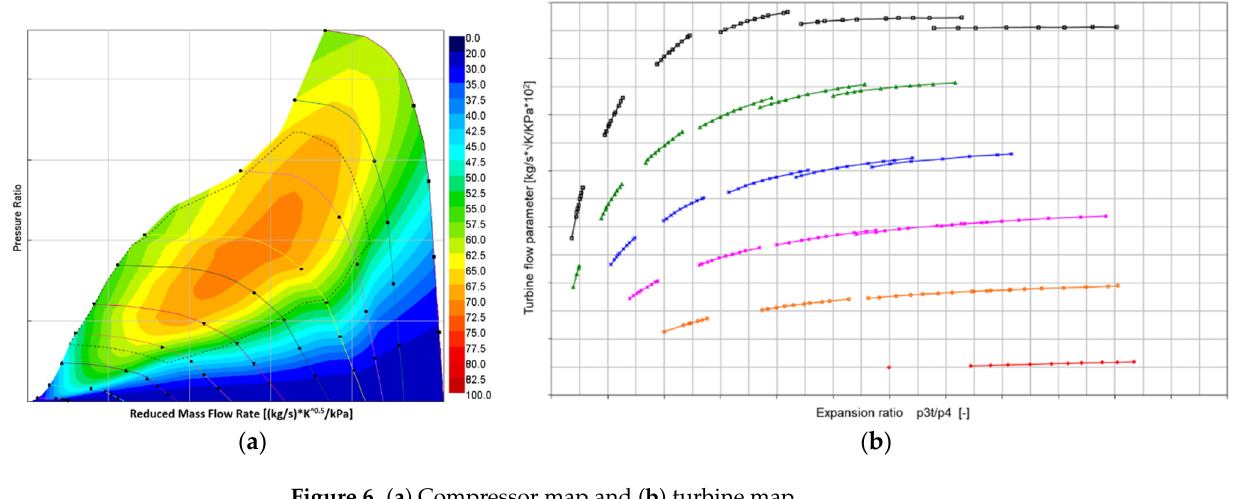
Figure 6. ( a ) Compressor map and ( b ) turbine map.